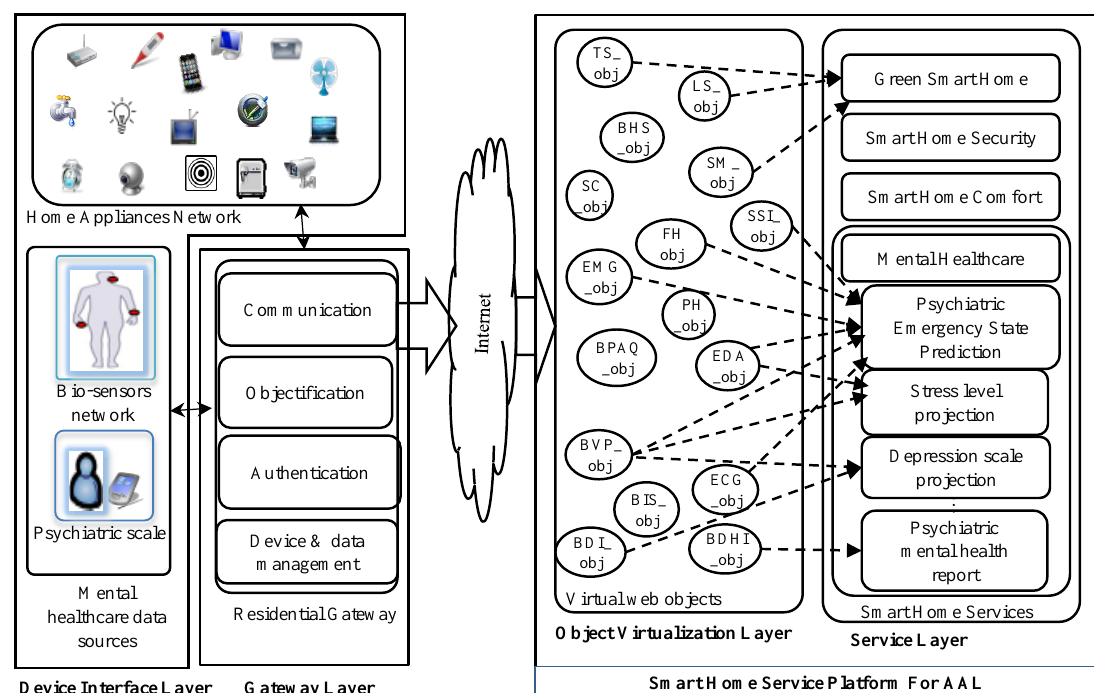
Figure 3. Web of Objects (WoO)-based smart home framework for ambient assisted living. Different home appliances and sensors are objectified as web of objects and virtualized in the virtualization layer. The virtualized web objects are defined as: TS, Temperature Sensor; LS, Light Sensor; BHS,